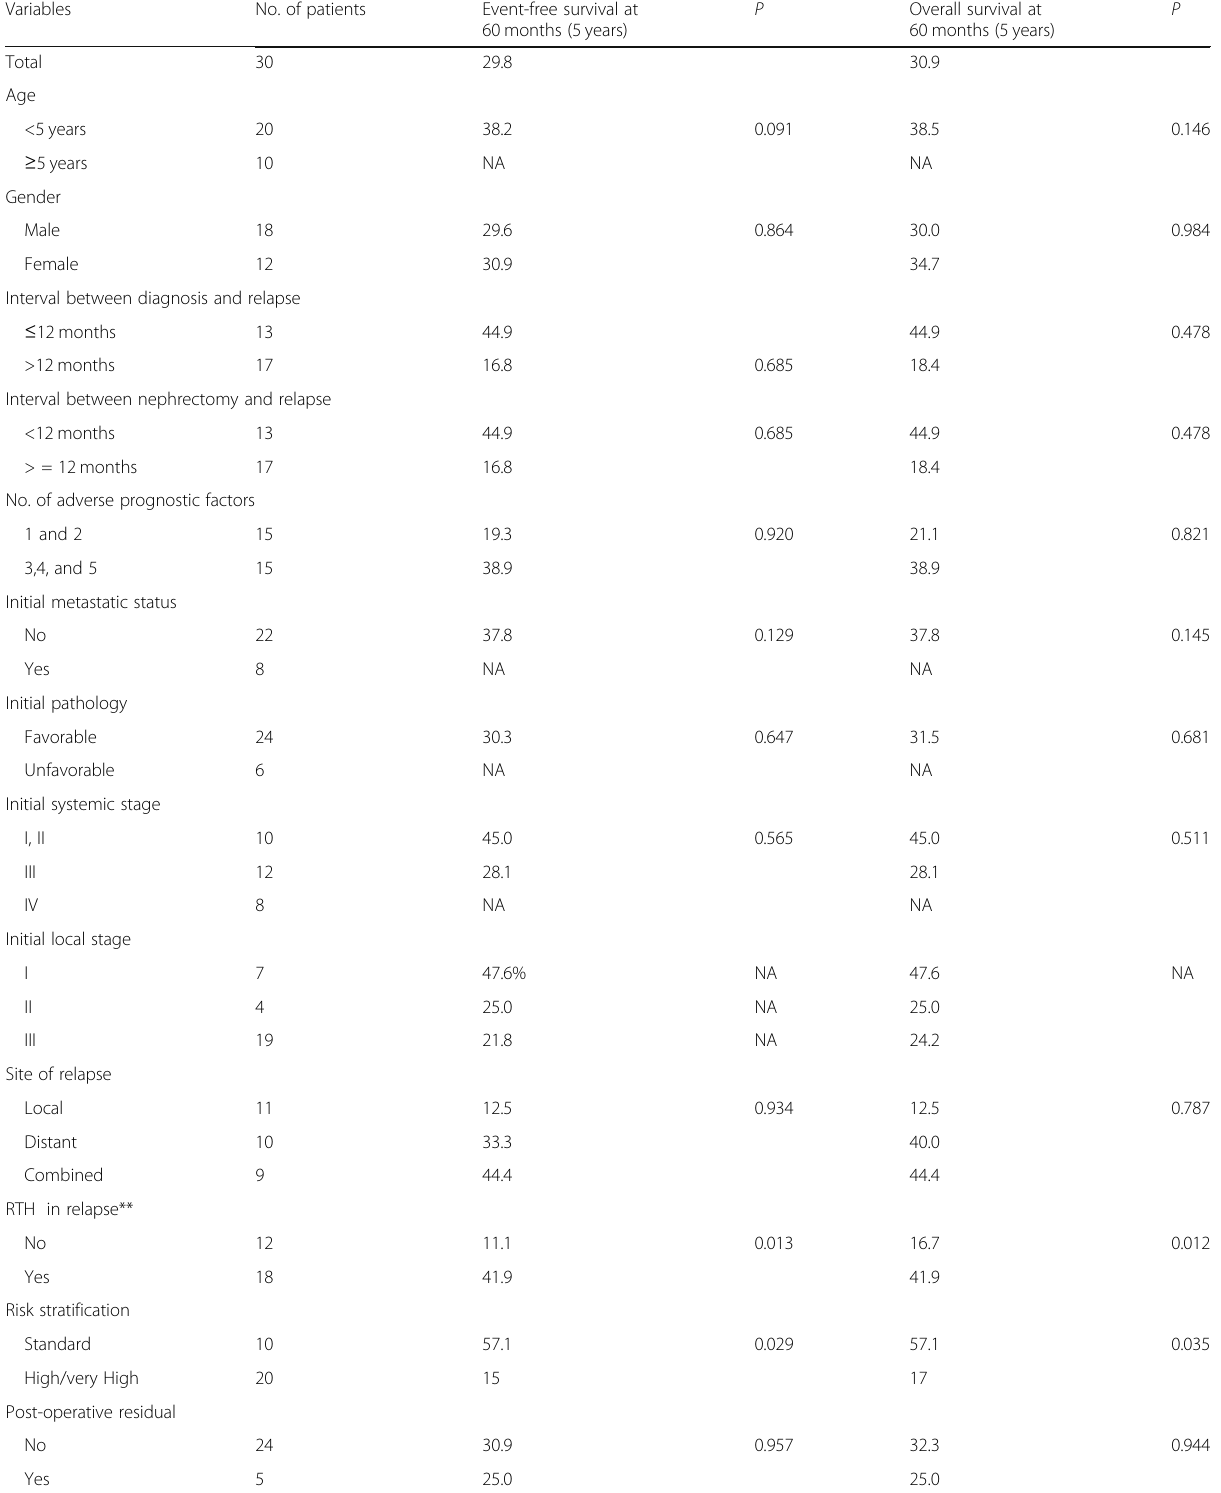
Table 3 Impact of different prognostic variables on survival outcome